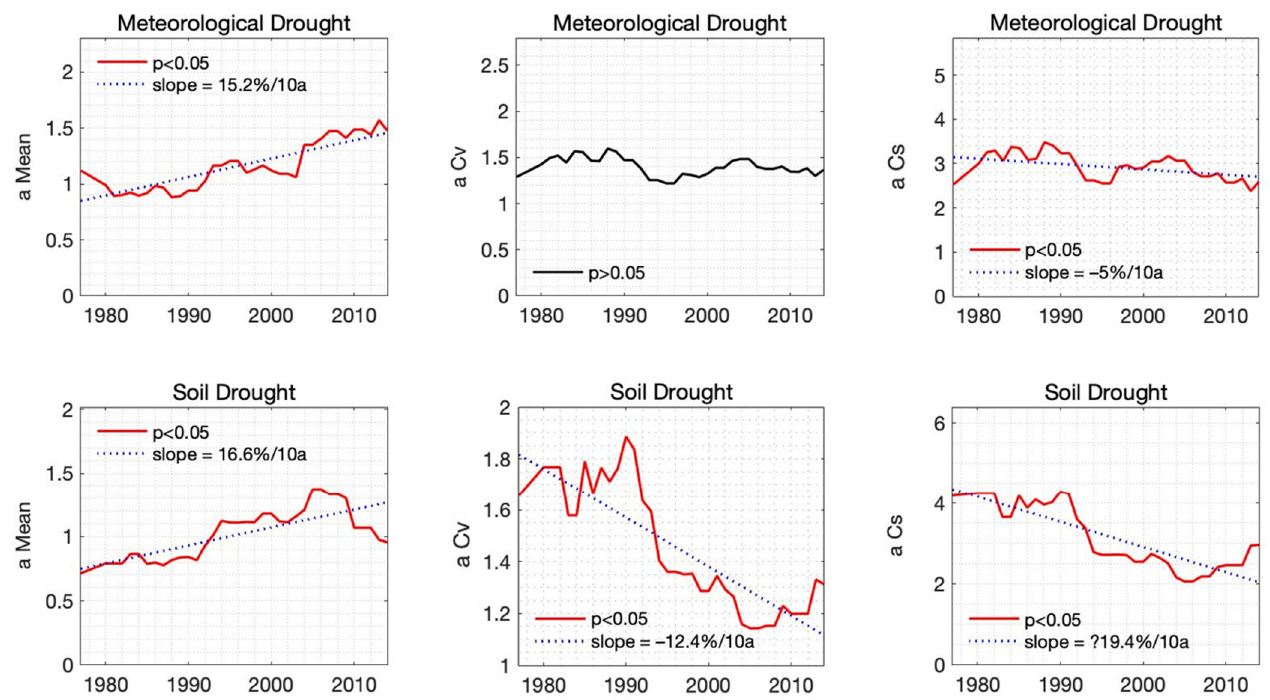
Figure 6. The change in the drought duration distribution. d refers to the continuous estimate of drought duration as Equation (1).